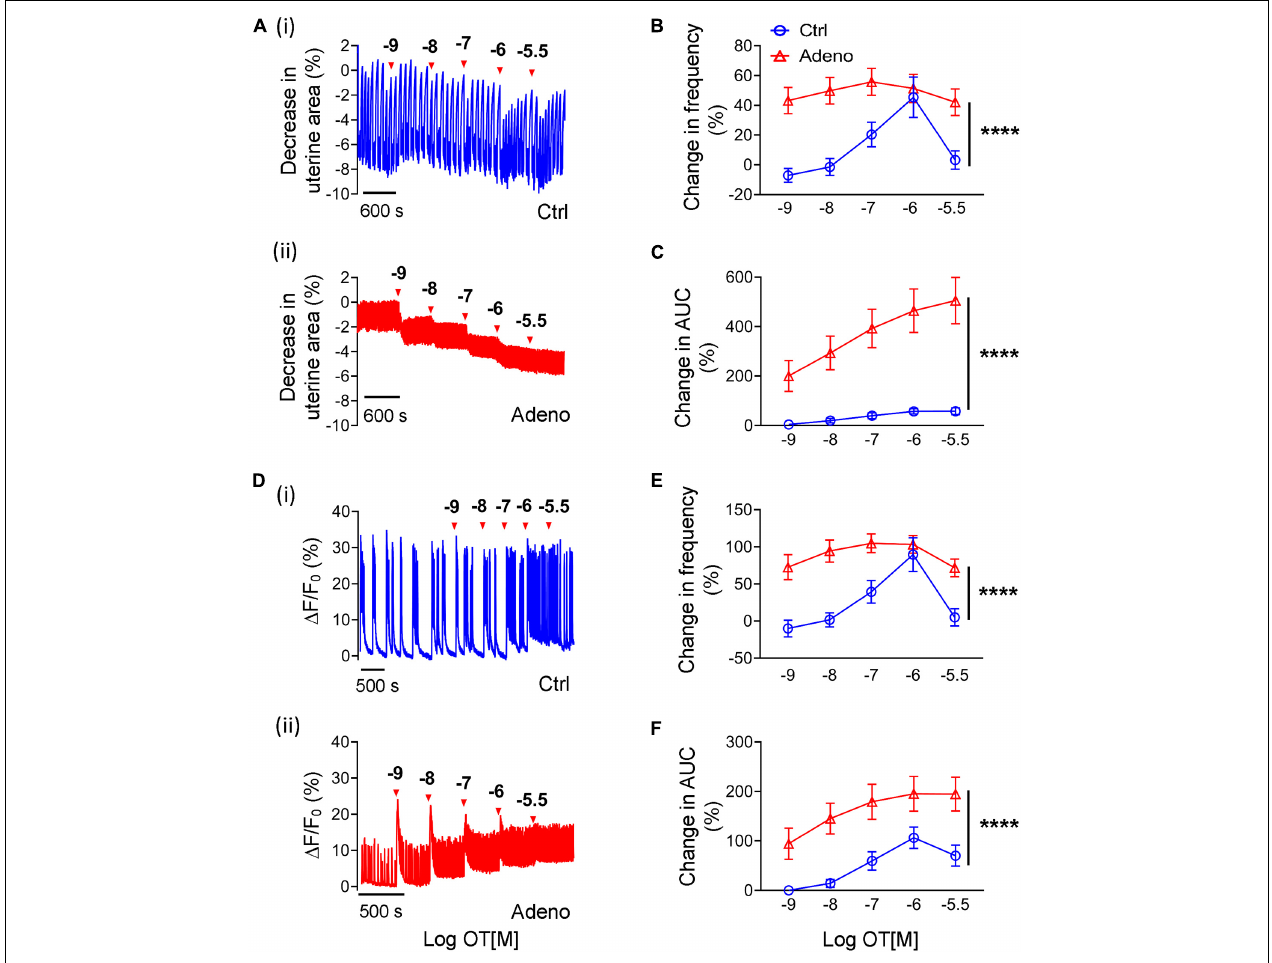
FIGURE 10 | Changes in oxytocin-induced uterine peristalsis and Ca 2 + oscillations in neonatal adenomyotic mice. (A) Time courses of uterine peristalsis in response to accumulative oxytocin (OT) stimulation in postnatal day (PND) 14 mice after treatment with the vehicle for tamoxifen (Ctrl) [A(i)] and the same age mice after treatment with tamoxifen (Adeno) [A(ii)] . The concentrations of OT are labeled above the traces. (B) Uterine peristalsis frequency changes caused by OT in uterine slices from Ctrl (O; blue line) and Adeno ( (cid:49) ; red line) mice at PND14. (C) Changes in the AUC of uterine peristalsis by OT in uterine slices from Ctrl (O; blue line) and Adeno ( (cid:49) ; red line) mice at PND14. (D) Time courses of Ca 2 + oscillations in response to accumulative OT stimulation in Ctrl [D(i)] and Adeno mice [D(ii)] at PND14. The concentrations of OT are labeled above the traces. (E) Ca 2 + oscillation frequency changes caused by OT in uterine slices from Ctrl (O; blue line) and Adeno ( (cid:49) ; red line) mice at PND14. (F) OT-induced changes in the AUC of Ca 2 + oscillations in uterine slices from Ctrl (O; blue line) and Adeno ( (cid:49) ; red line) mice at PND14. N = 5 Ctrl mice (10 slices) and 5 Adeno mice (10 slices) from for panels (B,C,E,F) . **** P < 0.0001 by a two-way